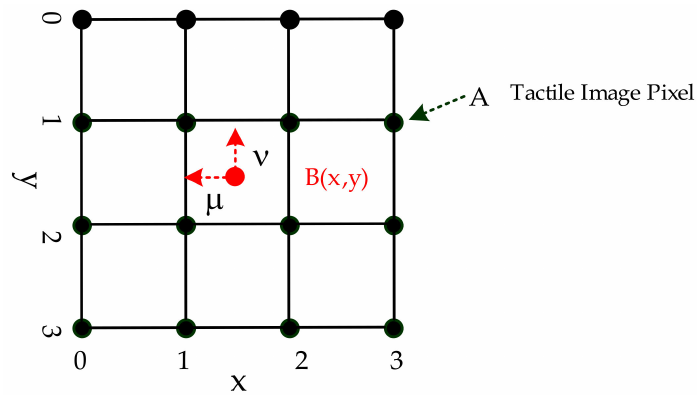
Figure 15. Bicubic interpolation